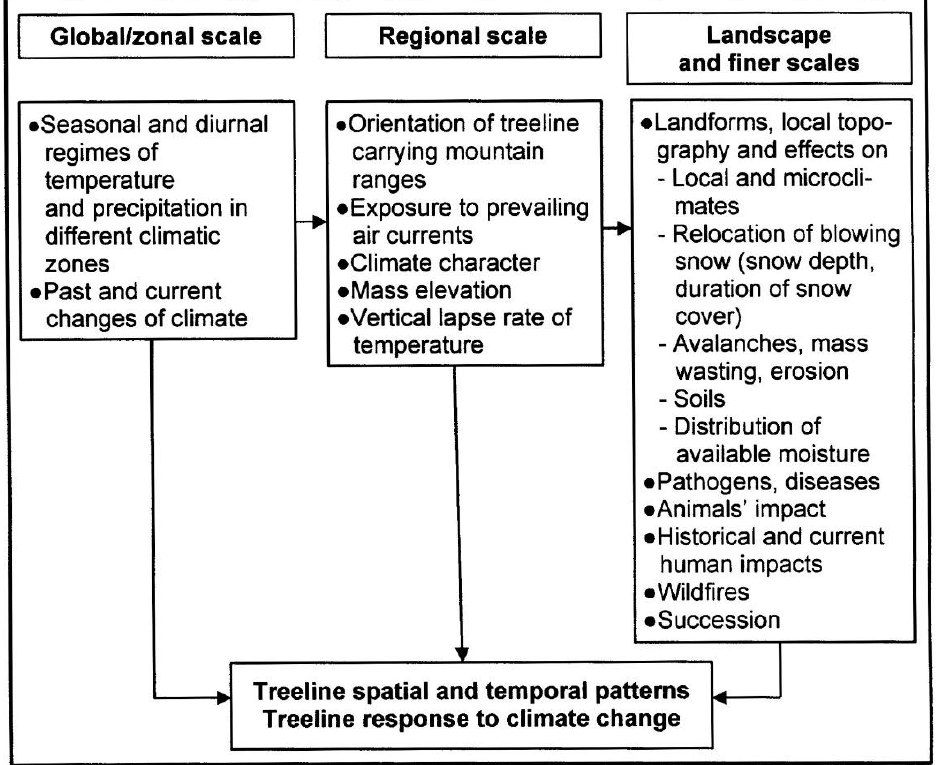
Figure 4. Combined results of research at different scales explain treeline spatio-temporal response to climate change.